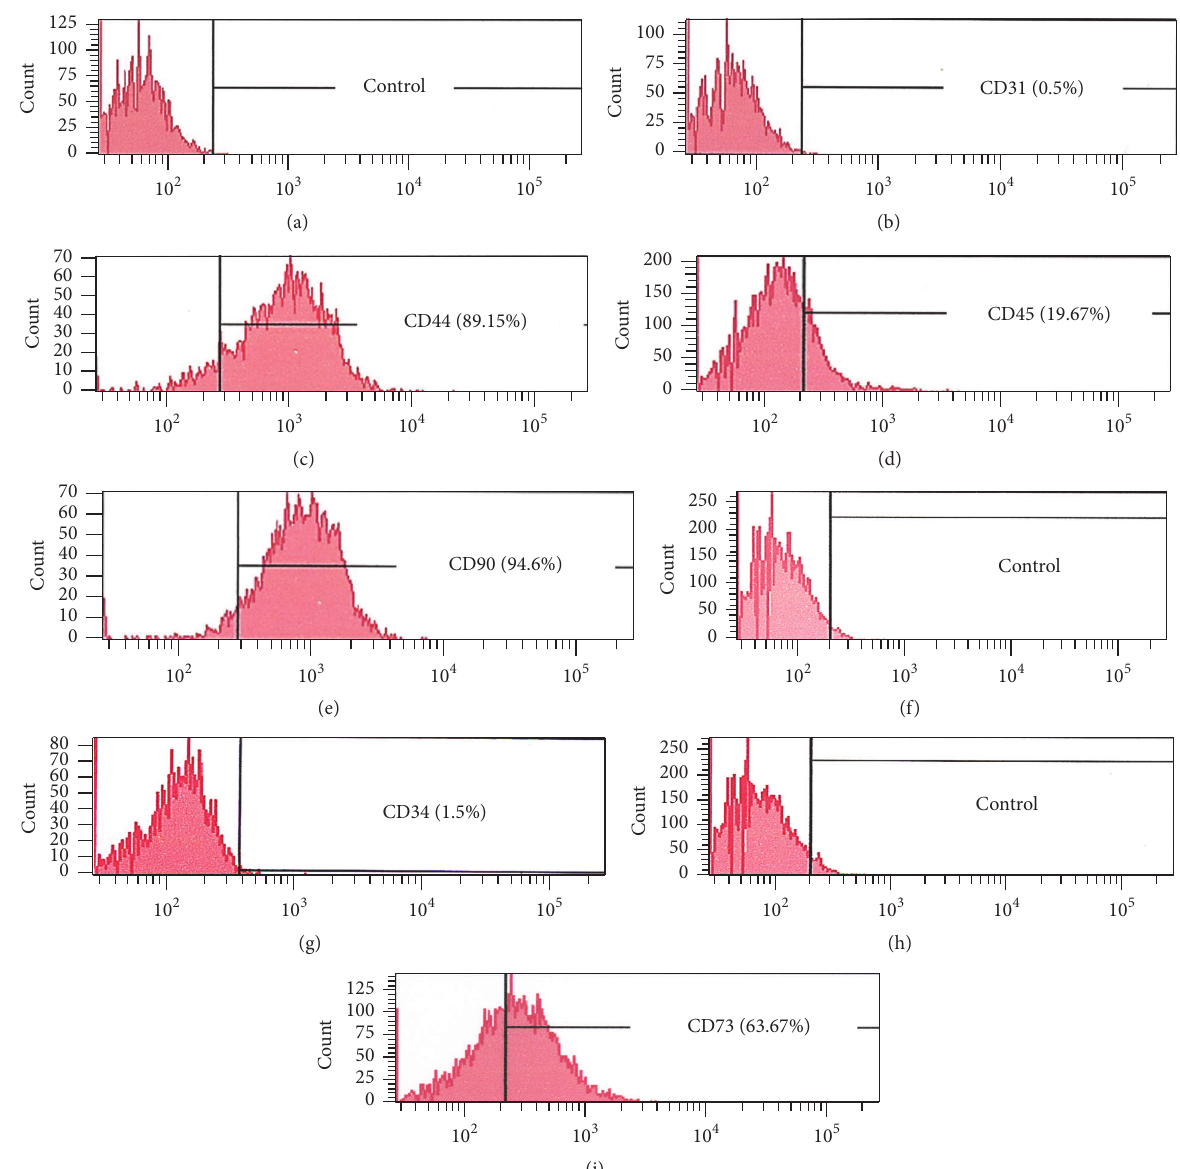
Figure 2: The characterization of ADSCs identified by flow cytometry. (a) FITC negative control result was obtained from ADSCs ( 1 × 10 6 ) incubated with FITC-conjugated goat anti-mouse IgG antibody only. (b) CD31 expression in ADSCs incubated with CD31 antibody and detected by FITC-conjugated second antibody. (c) CD44 expression in ADSCs incubated with CD44 antibody and identified by FITC- conjugated second antibody. (d) CD45 expression in ADSCs incubated with CD45 antibody and tested by FITC-conjugated second antibody. (e) CD90 expression in ADSCs incubated with CD90 antibody and determined by FITC-conjugated second antibody. (f) Negative control result of ADSCs incubated with Cy3-conjugated goat anti-rabbit IgG antibody only. (g) CD34 expression in ADSCs incubated with CD34 antibodyandidentifiedbyCy3-conjugatedgoatanti-rabbitIgGantibody.(h)NegativecontrolresultofADSCsincubatedwithCy3-conjugated donkey anti-goat IgG antibody only. (i) CD73 expression in ADSCs incubated with anti-CD73 antibody and identified by Cy3-conjugated donkey anti-goat IgG